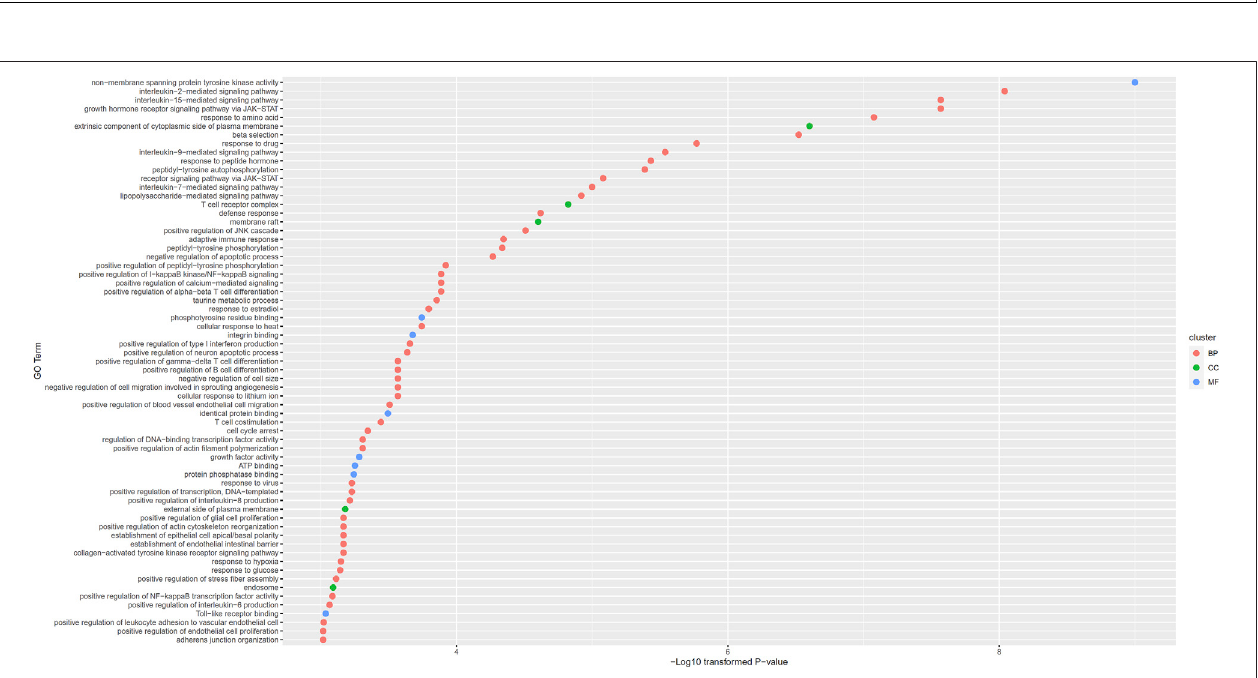
FIGURE5| Geneontology(GO)enrichmentresultsforputativegenesassociatedwithotitismedia.GOtermswith p -valuelessthan0.001areselectedandranked by their p -values.